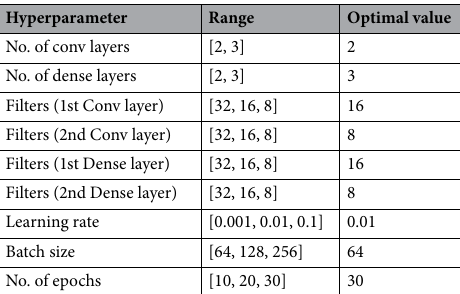
Table 1. Hyperparameter tuning of CNN architecture using RandomSearch algorithm.